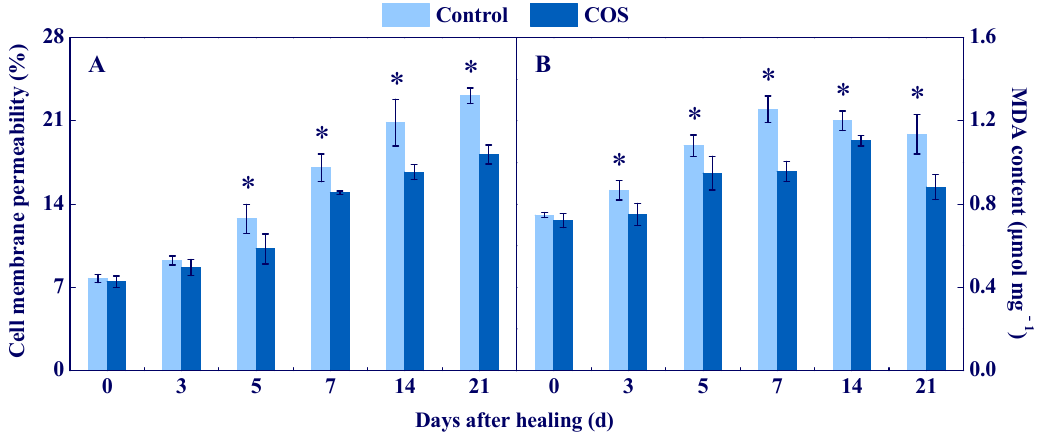
Figure 7. Effect of COS treatment on cell membrane permeability ( A ) and MDA content ( B ) at wounds of potato tubers during healing. Bars indicate standard error. Asterisks denote significant differences ( p < 0.05).